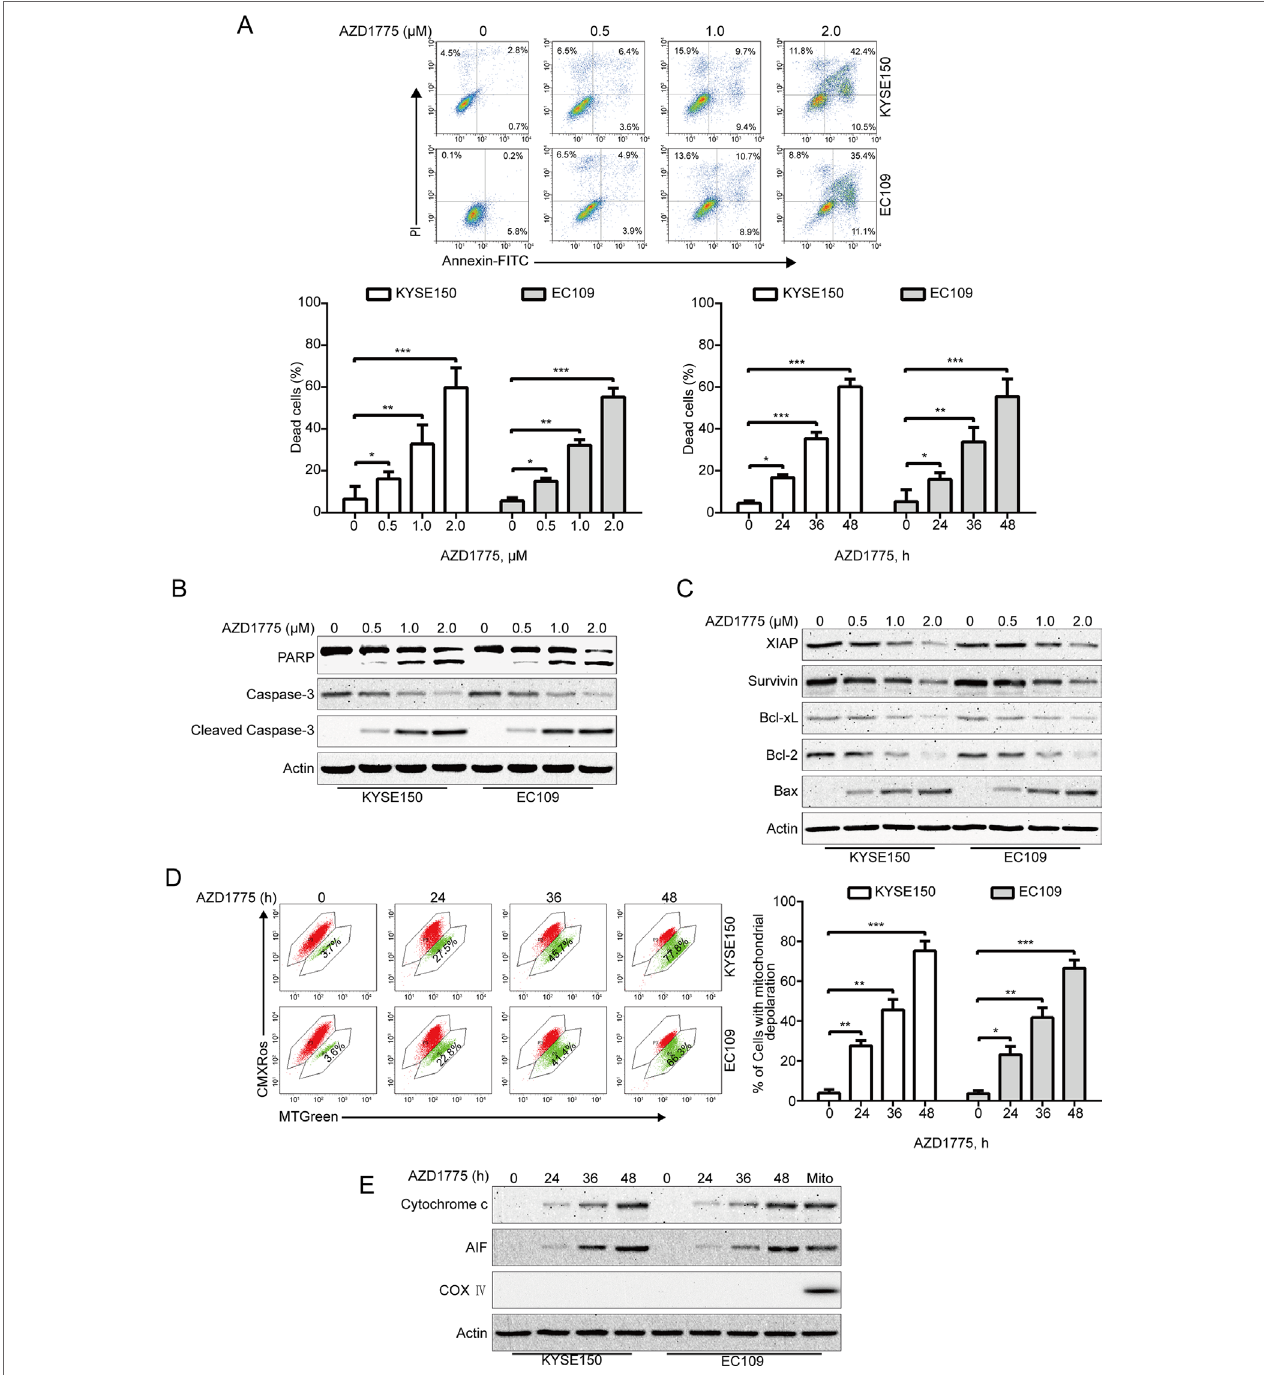
FIGURE 3 | AZD1775 triggers apoptosis in ESCC cells. (A) ESCC cells (KYSE150 and EC109) were treated with escalating concentrations of AZD1775 for 48 h, or 2.0 μ M AZD1775 for different times; cells were then subjected to flow cytometry analysis after dual staining with annexin V-FITC and PI. Upper panel: Representative histograms were shown. Lower panel: the vertical axis presents the sum of the top left and all right quadrants. Data are expressed as mean ± SD, from five independent experiments. * P < 0.05, ** P < 0.01, *** P < 0.001, one-way ANOVA with post hoc intergroup comparison by the Tukey’s test. (B, C) KYSE150 and EC109 cells were incubated with various concentrations of AZD1775 for 48 h, immunoblotting analysis was performed to detect the apoptosis-related proteins. Actin served as loading control. (D) KYSE150 and EC109 cells treated with or without 0.5 μM AZD1775 for increasing durations, and then, the mitochondrial membrane potential was assessed by flow cytometry after CMXRos/MTGreen double staining. Right: results from five independent experiments. * P < 0.05, ** P < 0.01, *** P < 0.001, one-way ANOVA with post hoc intergroup comparison by the Tukey’s test. (E) AZD1775 induced the release of cytochrome c and AIF into cytosol in ESCC cells. Levels of cytochrome c and AIF in the cytosolic extracts prepared with digitonin buffer were examined by western blotting analysis. The cytosolic fractionations were not contaminated as indicated by COX IV. Actin served as internal